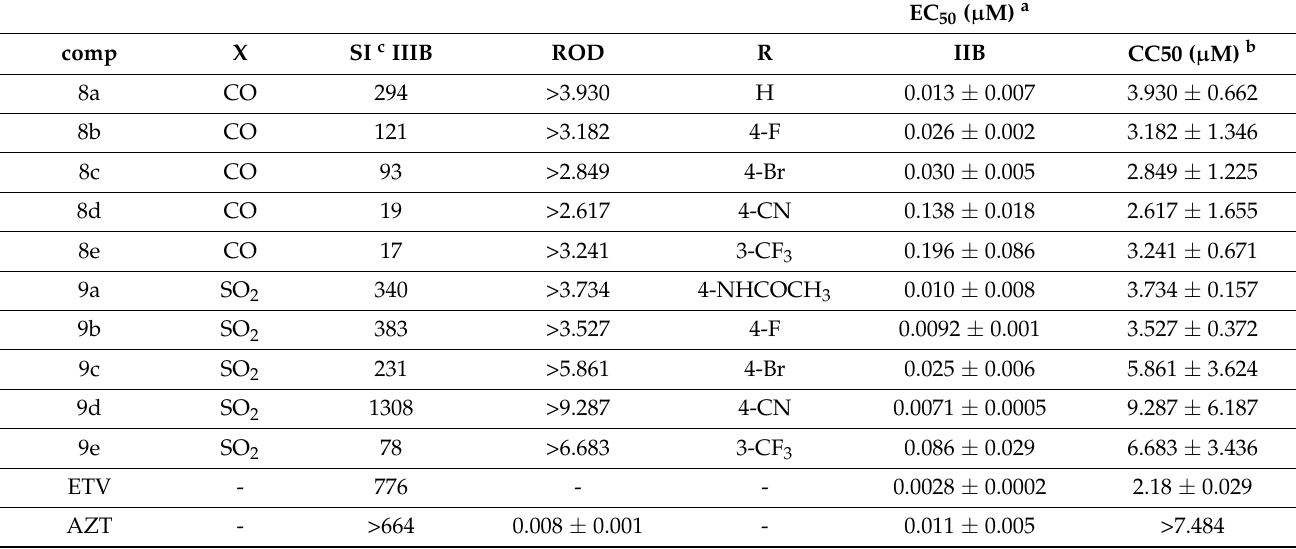
Table 2. Activity and Cytotoxicity against HIV-1 (IIIB) and HIV-2 (ROD) Strains in MT-4 Cells [69].